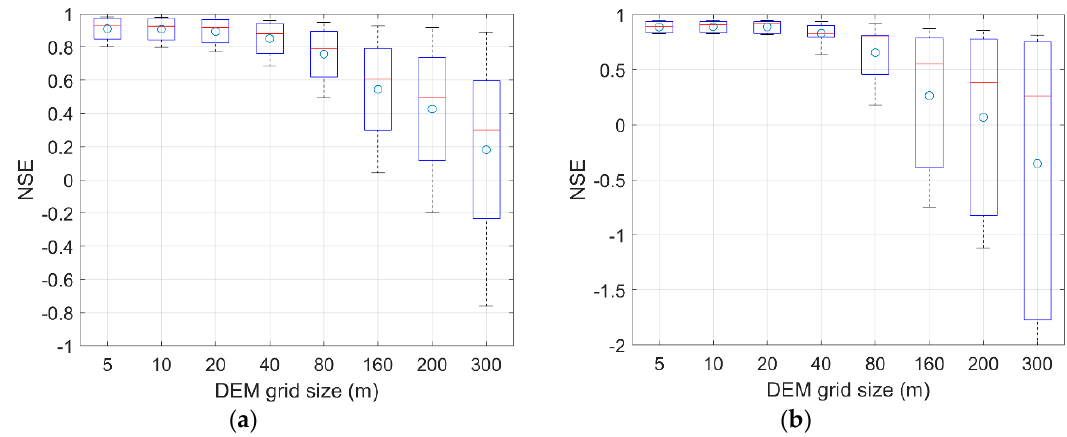
Figure 15. NSE (Nash–Sutcliffe efficiency) changes based on the resolution of the DEM grid cell size with constant parameter sets. ( a ) Dongkok watershed. ( b ) Ieemokjung watershed.